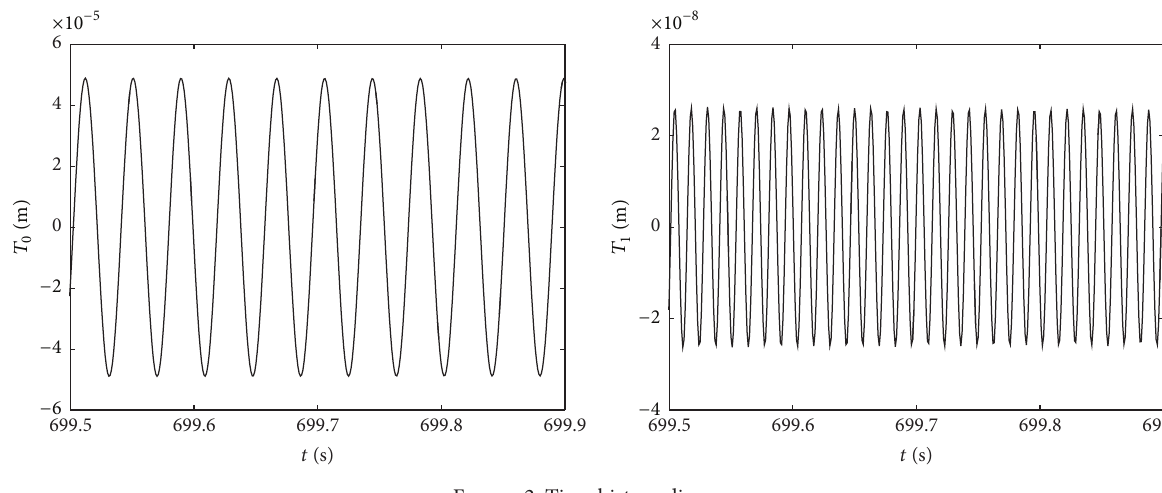
Figure 2: Time history